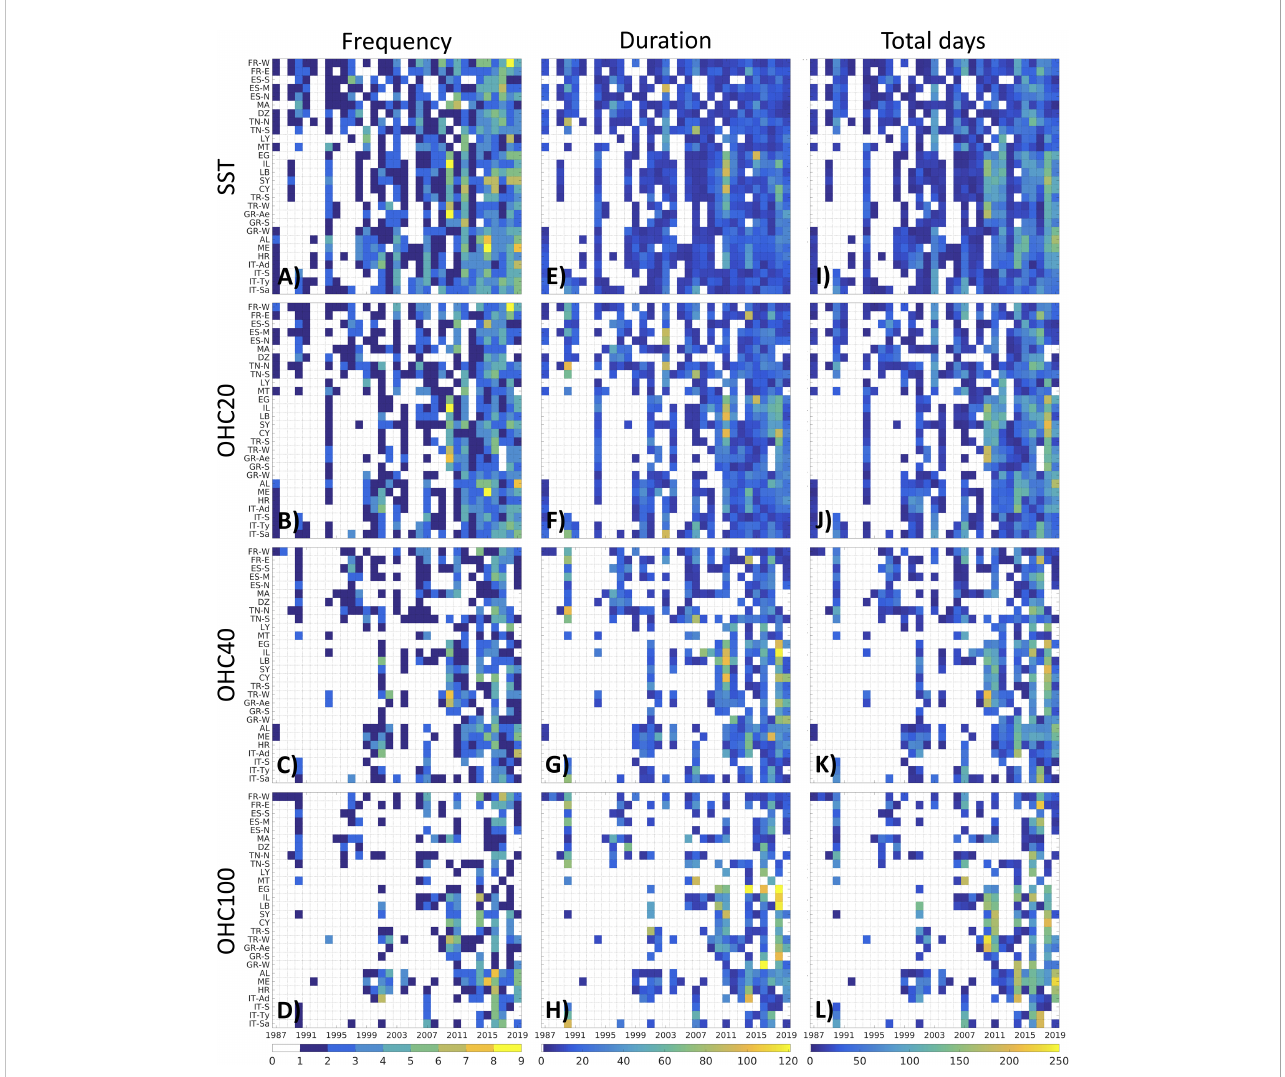
FIGURE 9 Annual means of MHW frequency (in count, A – D ), duration (in days; E – H ) and total days (in days; I – L ) over the period 1987 – 2019 in the different EEZs, computed from MEDREA SST ( A, E, I ), OHC within [0-20 m] (B, F, J) , OHC within [0-40 m] (C, G, K) and OHC within [0-100 m] (D, H, L)